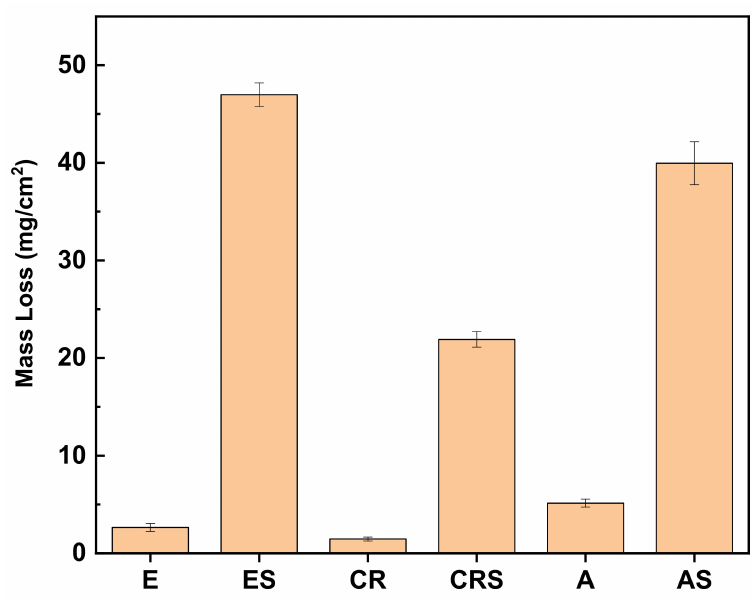
Figure 3. Nitric acid mass loss test (NAMLT) results of E, ES, CR, CRS, A, and